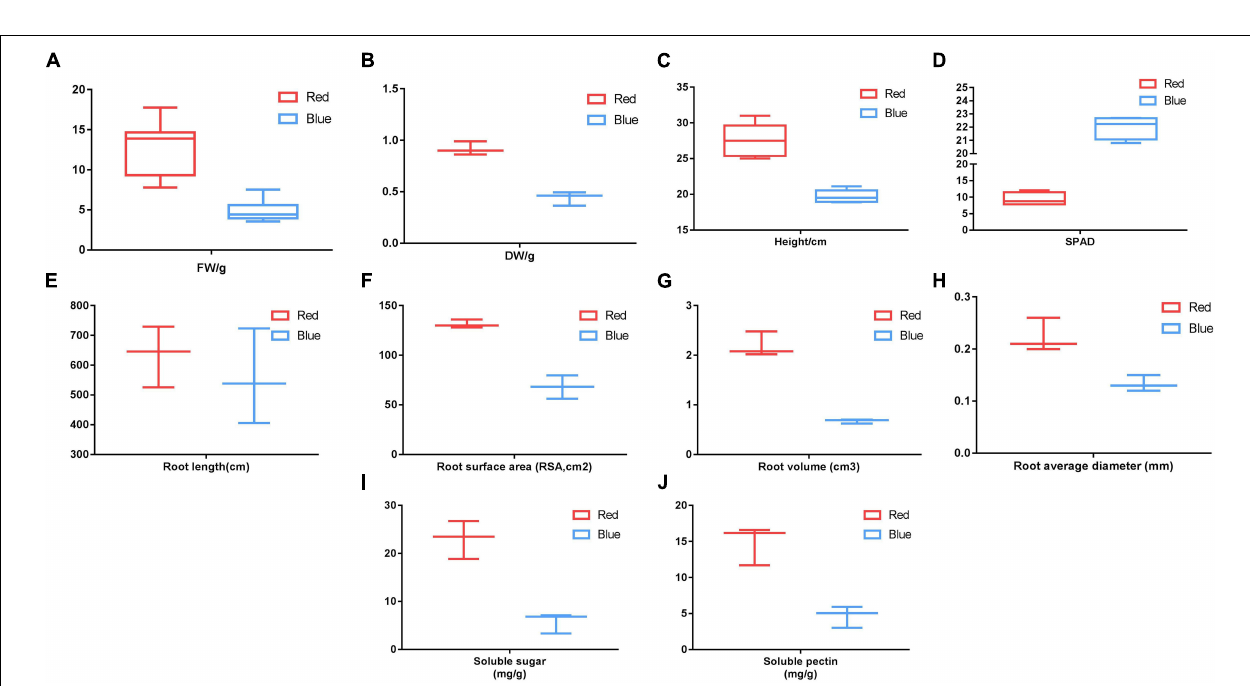
FIGURE 1 | Comparison of plant morphological characteristics and spectrum under the red and blue lights. (A,B) Blue- and red-light spectrum, respectively; Y-axis: λ pv, X-axis: wavelength; (C,D) The plants grown under the blue- and red-light conditions, respectively.